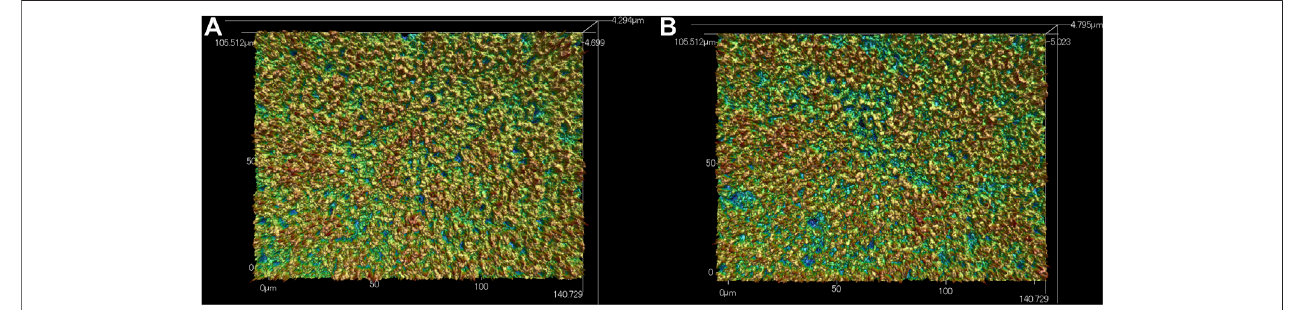
FIGURE 2 | Laser Microscopic images of the anodic oxides prepared in a sodium tartrate electrolyte. (A) indicates anodic oxides with H 2 O 2 , (B) indicates anodic oxides without H 2 O 2 . Three independent experiments were conducted. Representative results are shown.